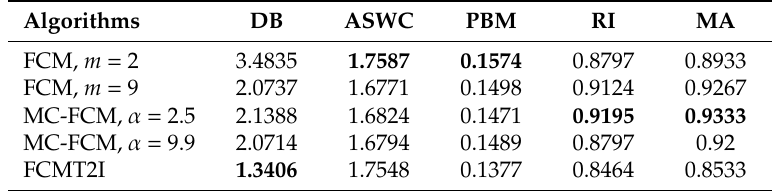
Table 5. Experimental results with the IRIS dataset, 150 samples, 3 clusters, m L = 1.1, m U = 9.1.